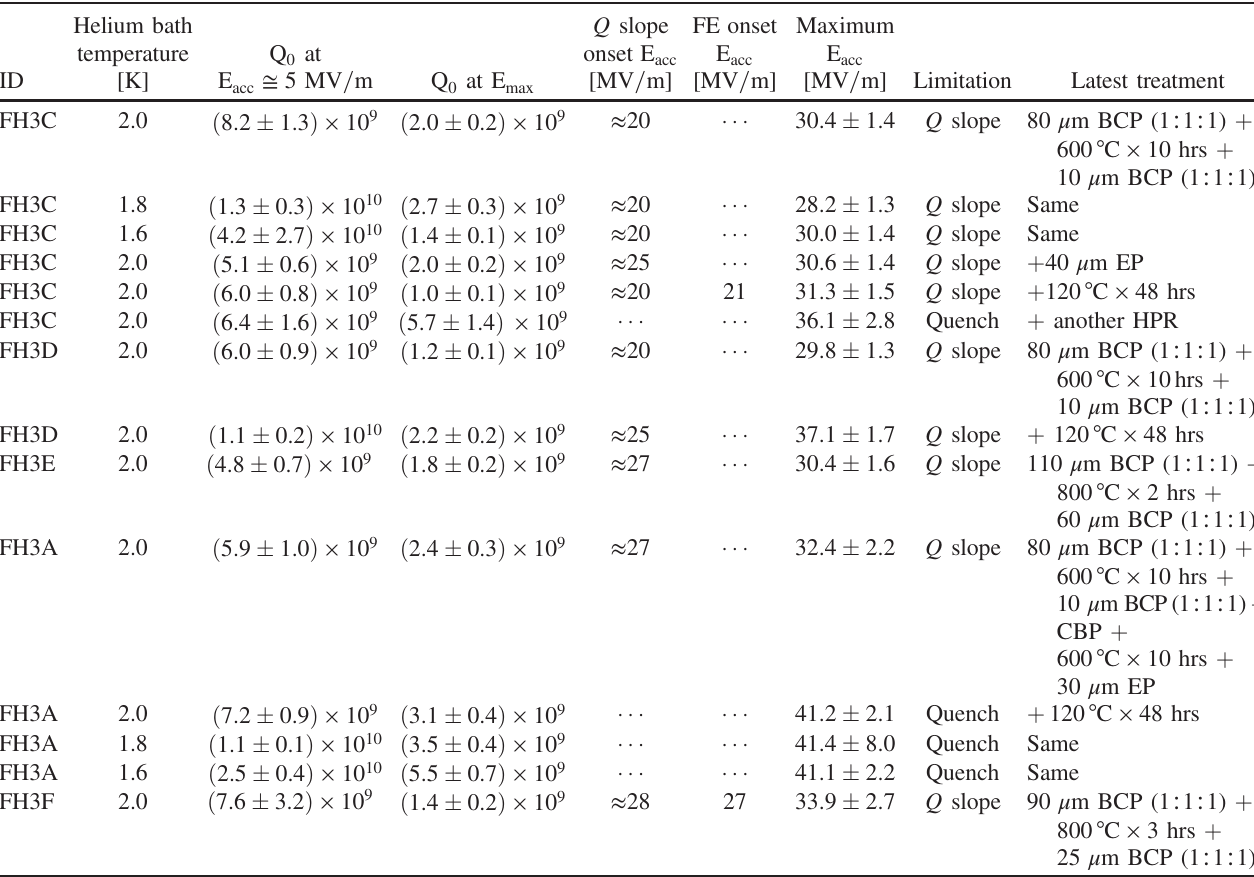
TABLE I. This table summarizes the results from all